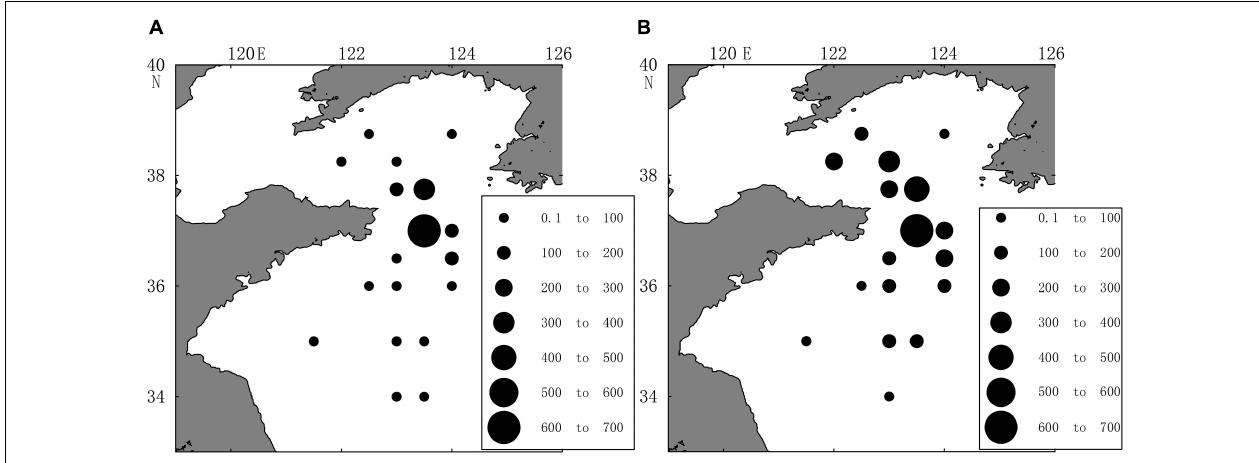
FIGURE 4 | Spatial distributions of Calanus sinicus abundance (ind/m 3 ) using the VPR (A) and net sample (B)